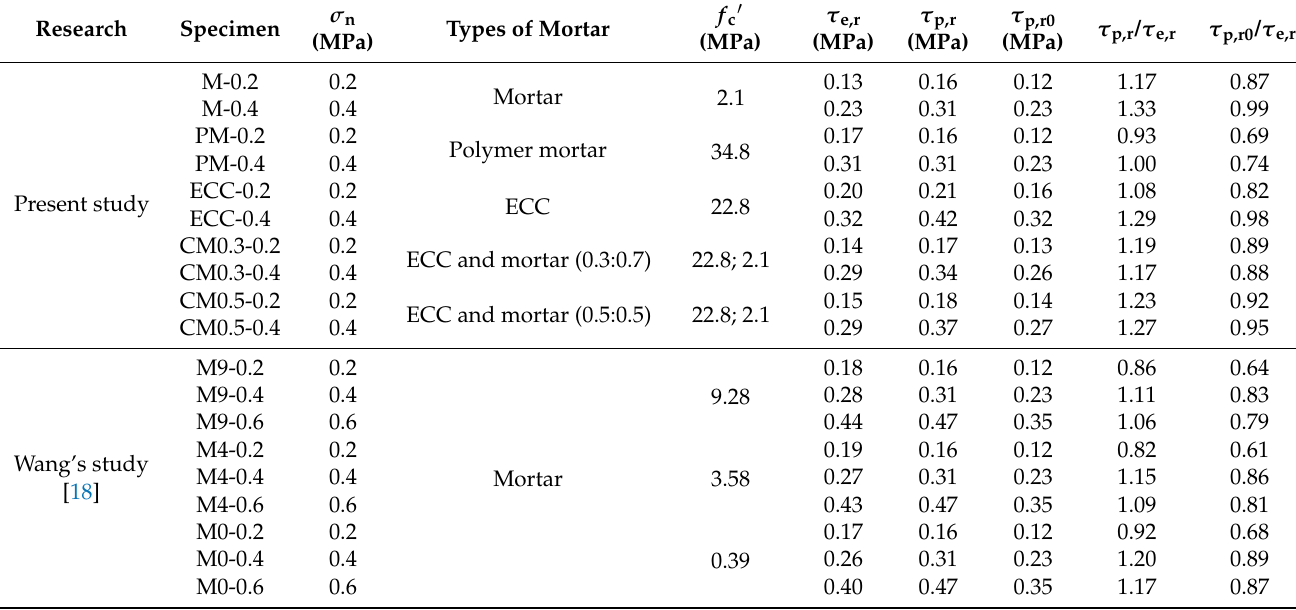
Table 6. Experimental and predicted results of residual shear